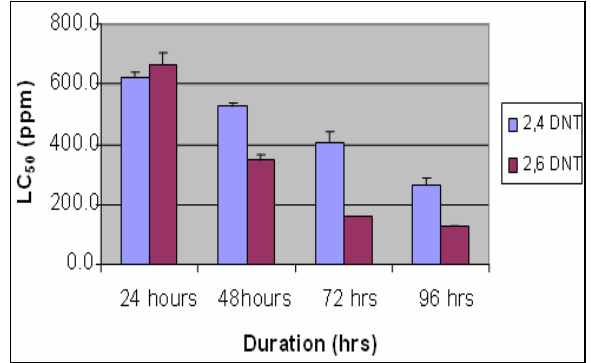
Figure 3: LC values of 2,4 and 2,6 DNT for lung cells 50 exposed at various